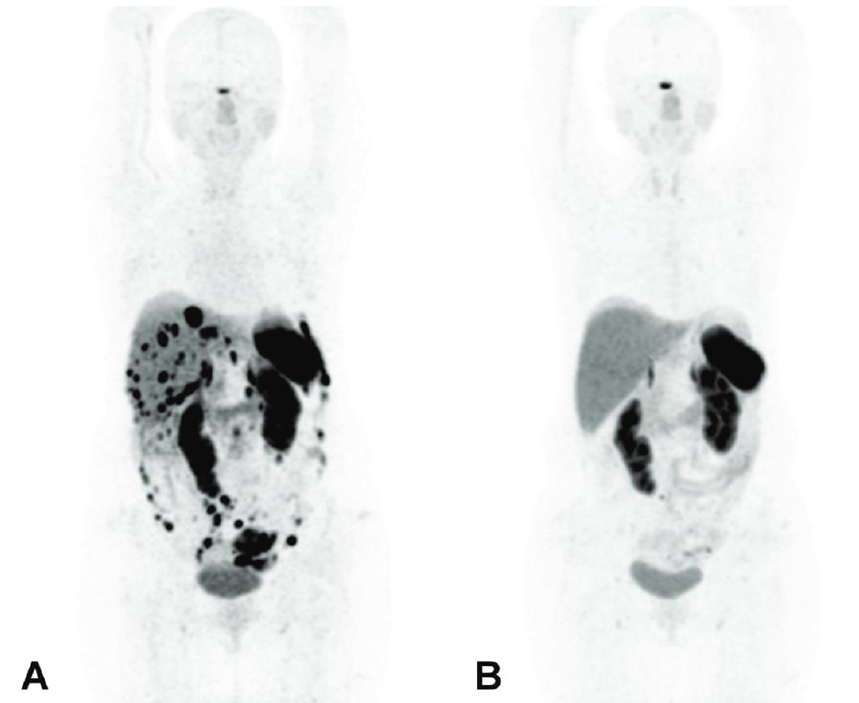
Figure 12. [ 68 Ga]Ga–DOTATATE PET/CT imaging before α-PRRT ( A ) showing >50 SSTR-positive abdominal lesions, and 3 months after a single cycle of 10 MBq [ 225 Ac]Ac–DOTATATE ( B ) showing the disappearance of all the abdominal lesions with the exception of a 5 mm lymph node in the para-aortic region [228].